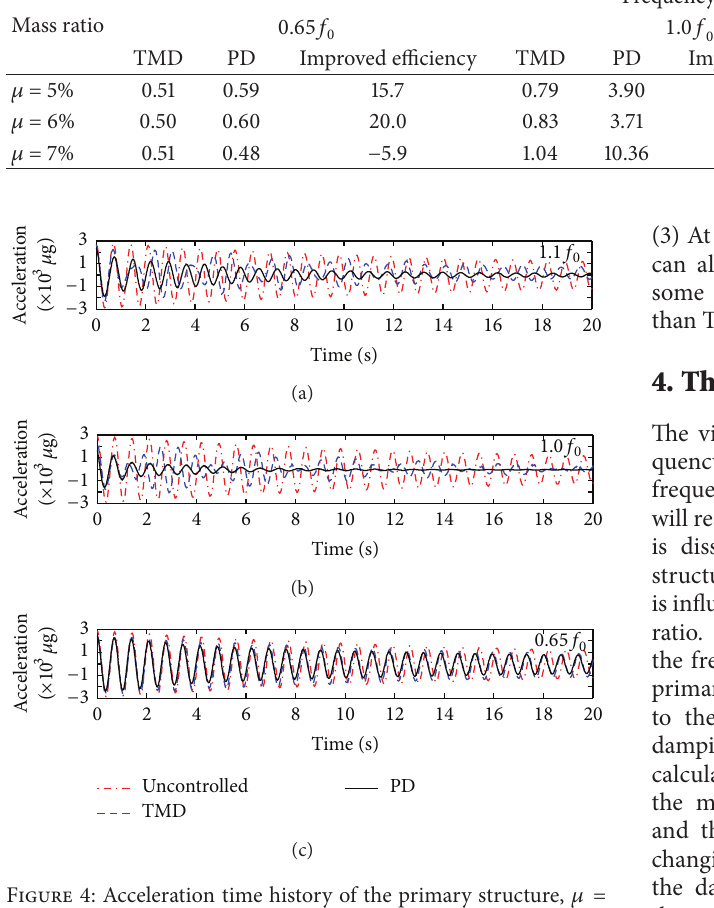
Figure 4: Acceleration time history of the primary structure, 𝜇 = 5